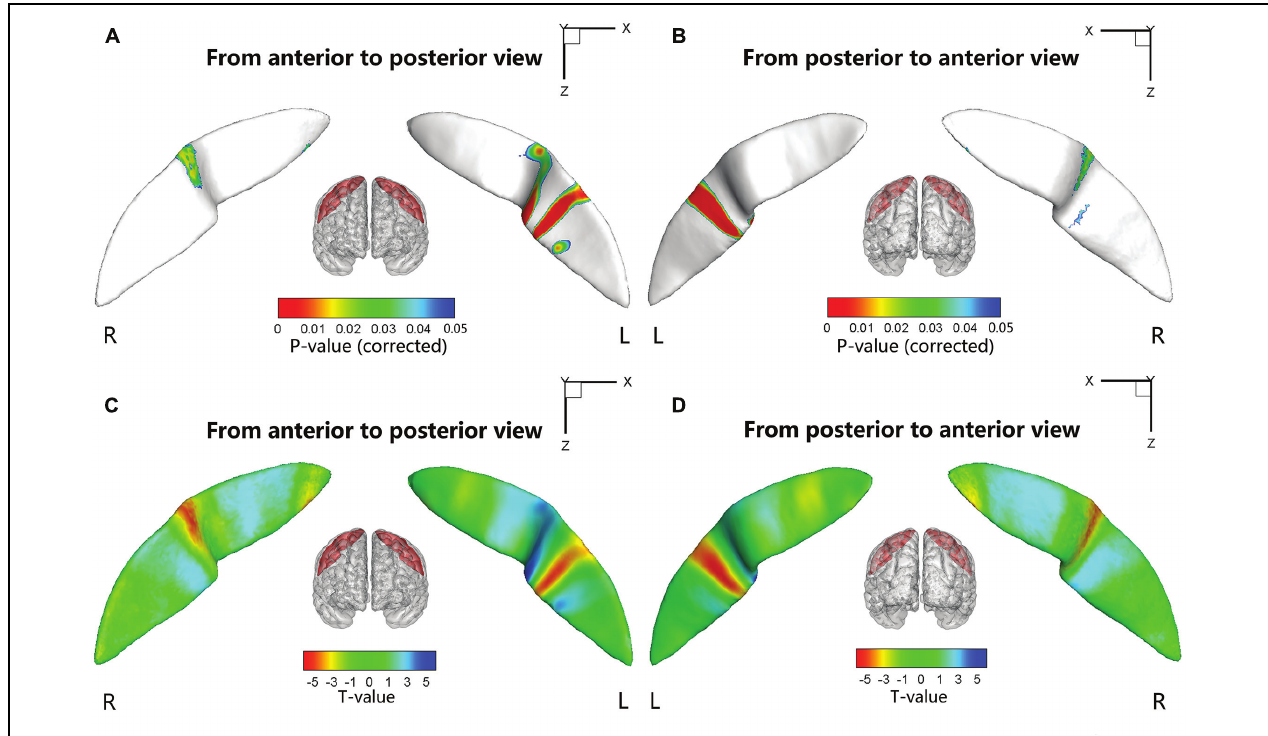
FIGURE 4 | Statistical differences of the node-based sulcal profile between the children with ADHD and the healthy children. Compared with the healthy children, the children with ADHD showed significantly ( P s < 0.05 after FDR correction; t < 0) nearer to the inertial plane (i.e., flat) in the middle section (i.e., somatotopic hand area; the direction of the sulcal profile in this area was positive on both sides of the CS) of the right CS. The anterior side of the left CS middle section also showed between-group differences. The upper-half part of this area in the children with ADHD was nearer to the inertia plane ( P < 0.05 after FDR correction; t > 0; the direction of the sulcal profile in this area was positive), whereas the lower-half part was farther away from the inertial plane ( P < 0.05 after FDR correction; t > 0; the direction of the sulcal profile in this area was negative). For the lower section of the left CS, the children with ADHD